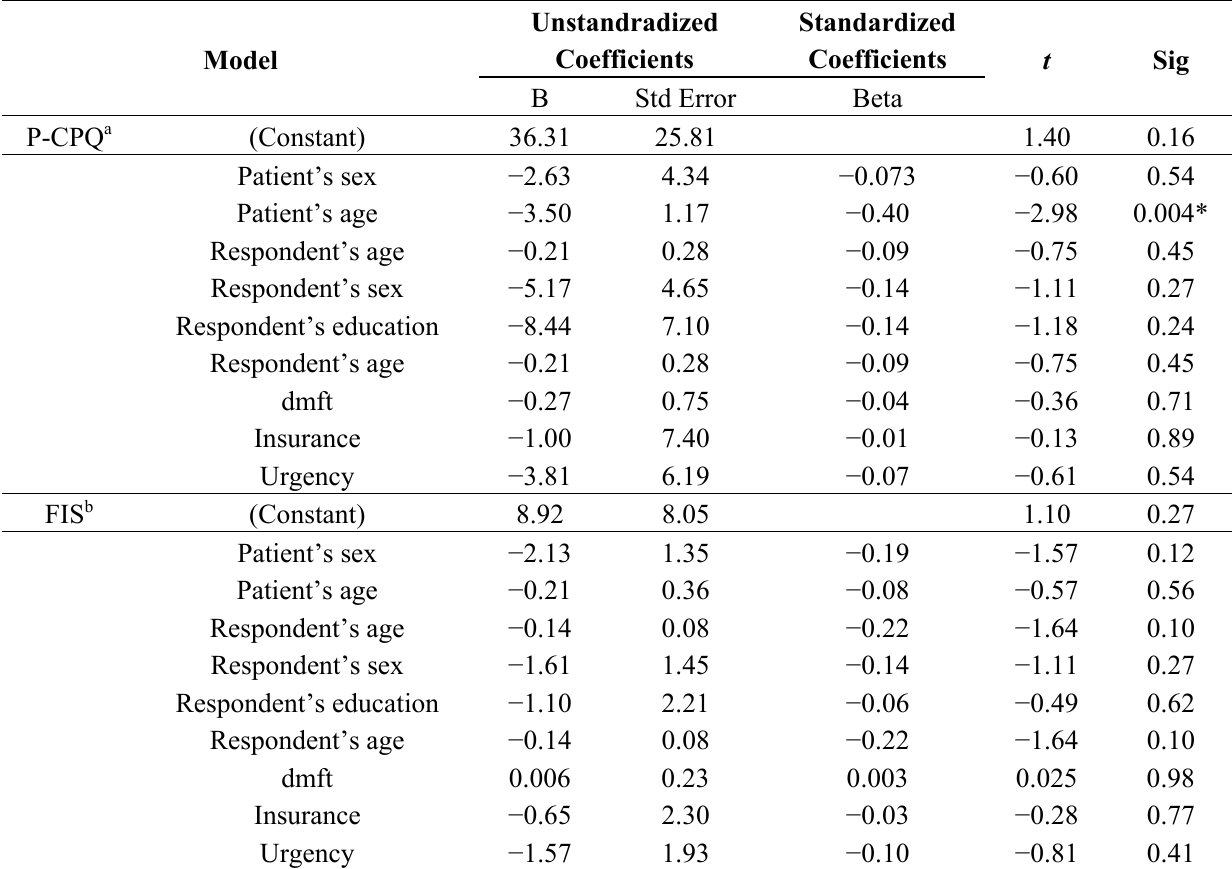
Table 3. Multiple linear regression of epidemiological variables effects on pretreatment P-CPQ and FIS